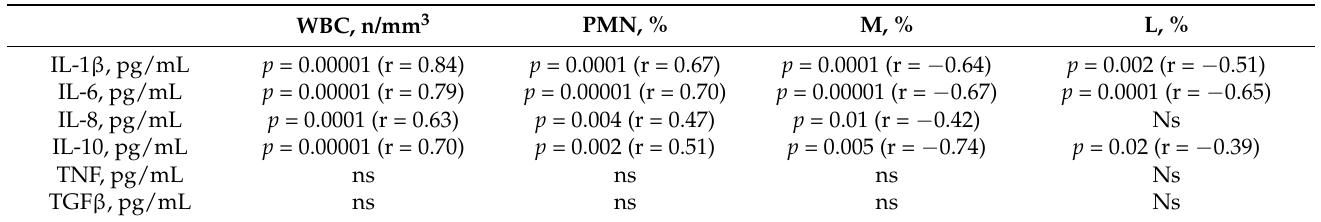
Table 4. Correlations between SF cytokine, chemokine, and growth factor levels and cellular inflam- matory indices.